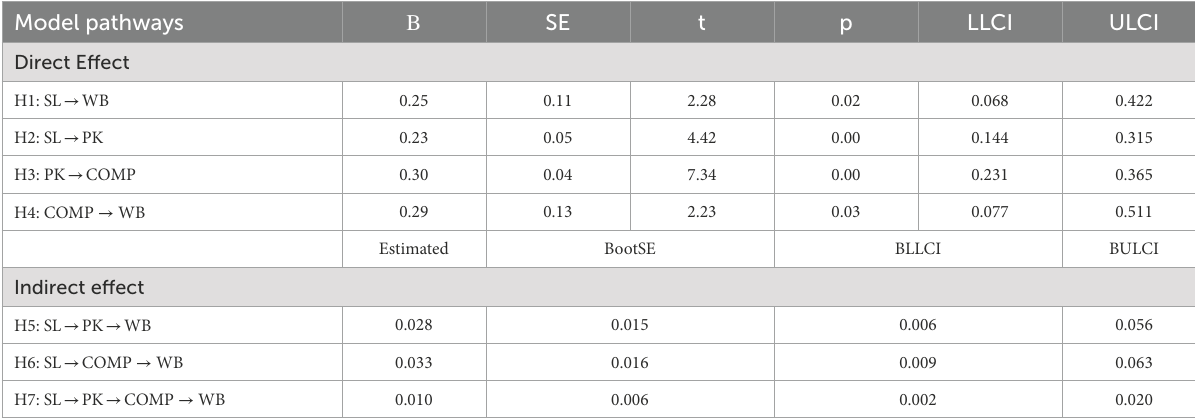
TABLE 4 Results of sequential mediation (direct and indirect effects). Model